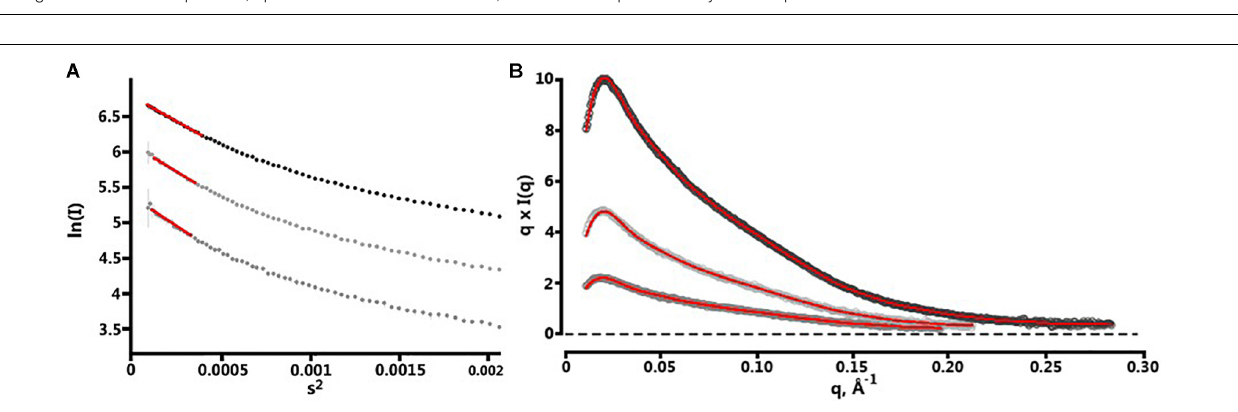
FIGURE 3 | Structural alignment of BT2857C, BT3158, and CBM32 from C. perfringens . BT2857C is depicted in blue, BT3158 in green, CBM32 (RCSB: 2J1E) in gray, and associated ligands or solvent in ball-and-stick. CBM32 is shown coordinated to β -d-galactosyl-1,4- β -d-N-acetylglucosamine (white). (A) There is high structural similarity in the C-terminal domains (DUF5000 or E c domain) of BT2857 and BT3158 with CBM32 from C. perfringens (RMSD = 2.051 and 1.991 Å, respectively). The majority of the overall fold is conserved across the three structures but diverge at the carbohydrate accommodation portion of CBM32. (B) Intriguingly, in both BT2857C and BT3158 crystallographic ethylene glycols (EDO) that was supplemented during crystallization and used as a cryoprotectant were found in the carbohydrate accommodation position of CBM32. (C) Residues contributed (numbering presented for BT2857) at the CBM accommodation site diverge across the three proteins, apart from a conserved histidine, H265 which is presented by all three proteins.